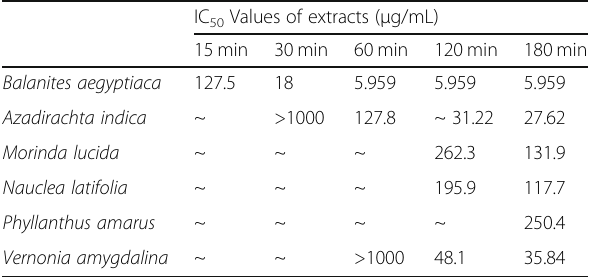
Table 1 IC 50 values of various extracts in μ g/mL of the different time intervals IC 50 Values of extracts ( μ